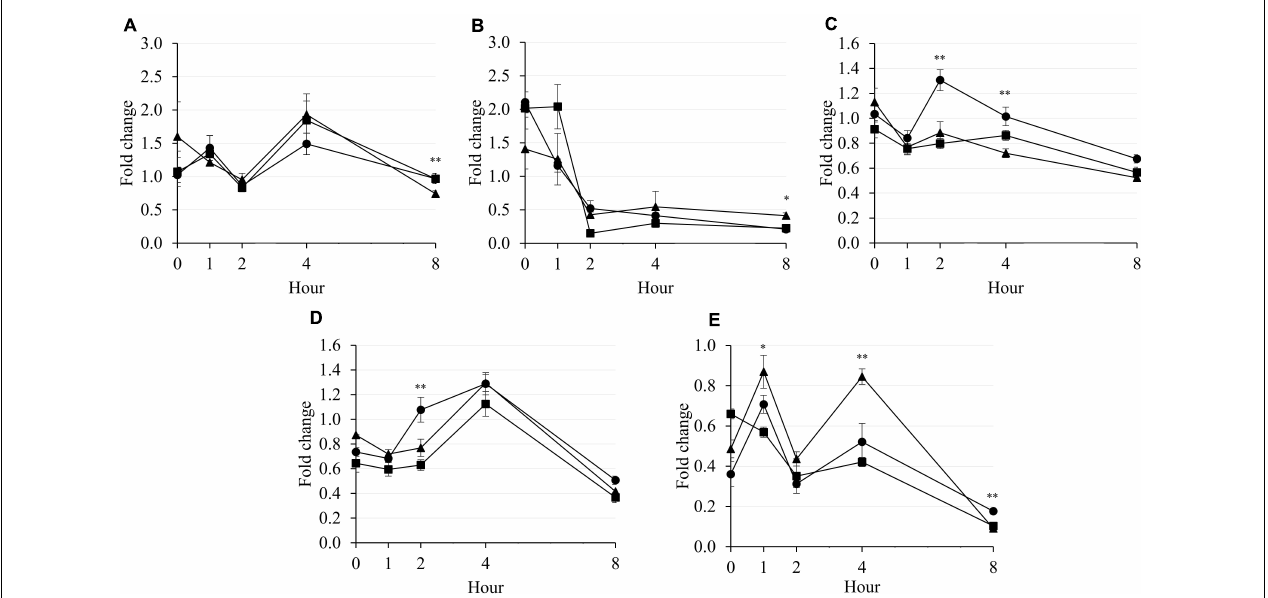
FIGURE 3 | Fold change in methanogenic archaea (A) , rumen ciliate (B) , F. succinogenes (C) , R. flavefaciens (D) , and R. albus (E) compared with that of the blank during rumen incubation with FAs for 8 h. Diet with C18:2n-6, LA (filled circles); diet with C18:3n-3, LNA (filled triangles); and diet with the mixture of C18:2n-6 and C18:3n-3 at a ratio of 1:1 (filled squares). The respective significance levels of the supplementary treatment, incubation period, supplementary treatment × incubation period, and SEM for methanogenic archaea, rumen ciliates, F. succinogenes , R. flavefaciens , and R. albus are P = 0.255, P = 0.157, P = 0.492, and SEM = 2.046; P < 0.001, P = 0.458, P = 0.019, and SEM = 0.344; P < 0.001, P < 0.001, P = 0.003, and SEM = 0.124; P < 0.001, P = 0.032, P = 0.301, and SEM = 0.168; and P < 0.001; P = 0.001, P < 0.001, and SEM = 0.099. Different symbols at the same hour differ significantly. ∗ P < 0.05; ∗∗ P < 0.01.